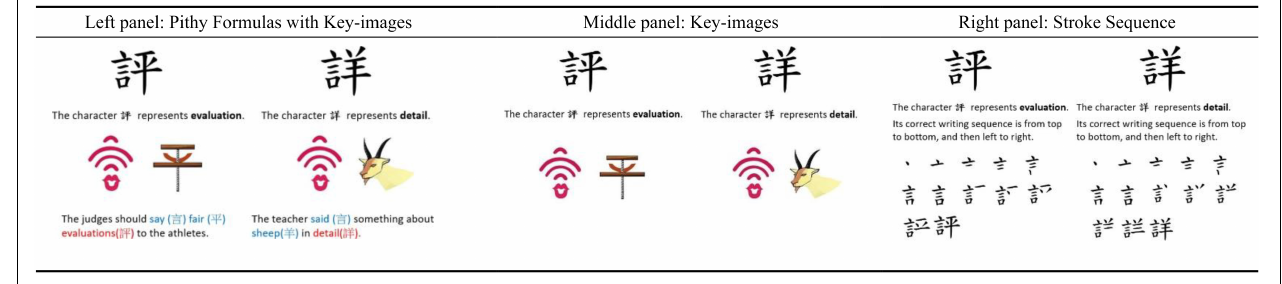
FIGURE 2 | Illustrations showing the three different strategies for learning character pair (in the similar group)